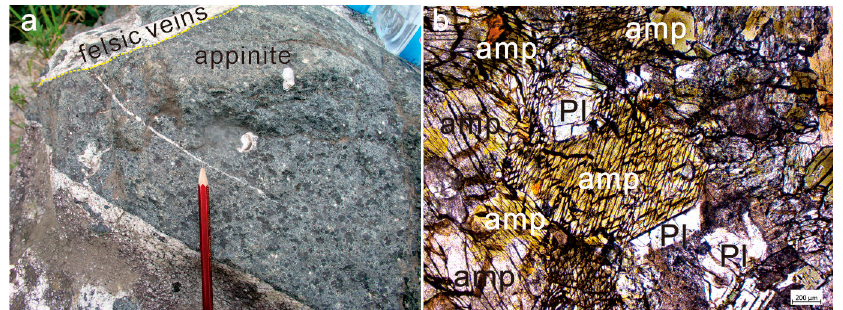
Figure 2. Field photo and microscope pictures for the appinite in the Laocheng pluton amp- amphi- bole; Bi-biotite; Kfs-K-feldspar; Pl-plagioclase; Qtz-quartz. ( a ) field photo of the Laocheng appinite; ( b ) microscope picture of the Laocheng appinite.